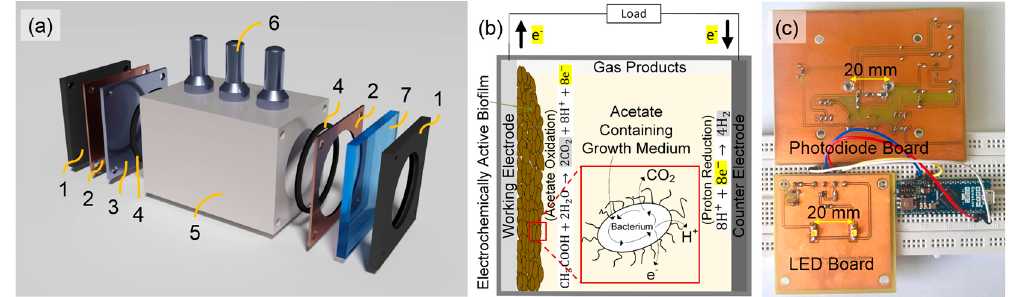
Figure 1. ( a ) 3D sketch of a homebuilt miniaturized bio-electrochemical reactor consisting of (1) the reactor cover frames, (2) the adhesive copper tape, (3) the counter electrode, (4) the O-rings, (5) the reactor chamber with (6) three tube fittings and (7) the GaN working electrode; ( b ) Scheme of a microbial electrolysis cell (MEC) with highlighted bacterial metabolism (inset); ( c ) Current status of the sensor system. The photodiode and LED board can be screwed on the outside of both rector